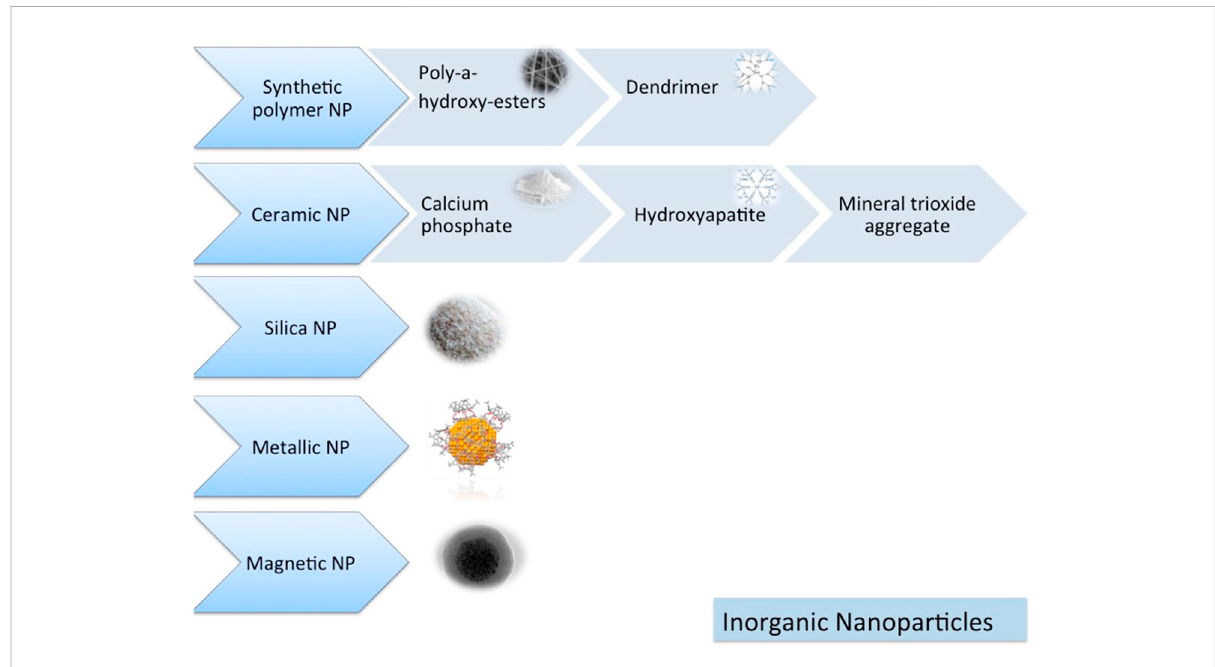
FIGURE 5 Inorganic nanomaterials (Funda et al., 2020).